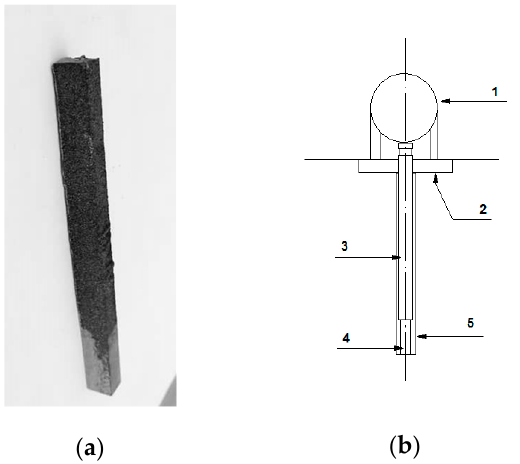
Figure 4. ( a ) Photograph of chromium cast iron ingot intended for dilatometric sample; ( b ) dilatome- ter construction diagram (1—Capacitive displacement sensor; 2—Fixing element; 3—Pusher, 4—Sample; 5—Protective quartz tube).